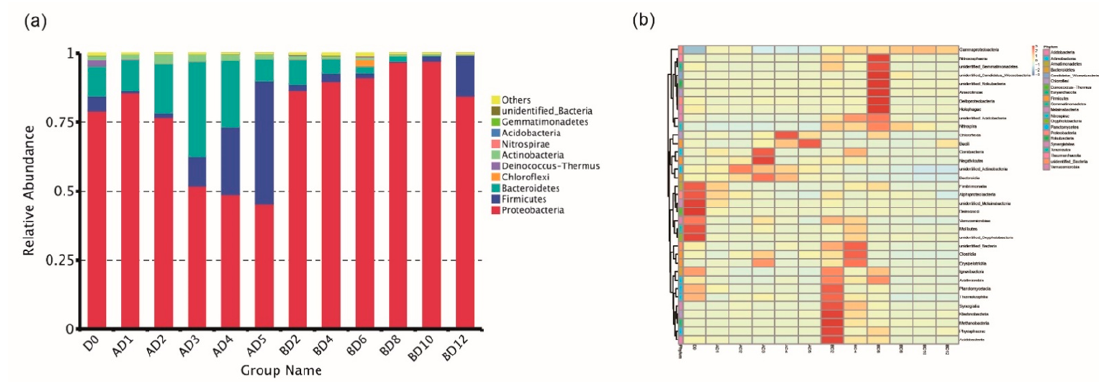
Figure 2. ( a ) Column chart showing the species relative abundances at the Phylum -level and ( b ) clustering heat map at the Class -level.